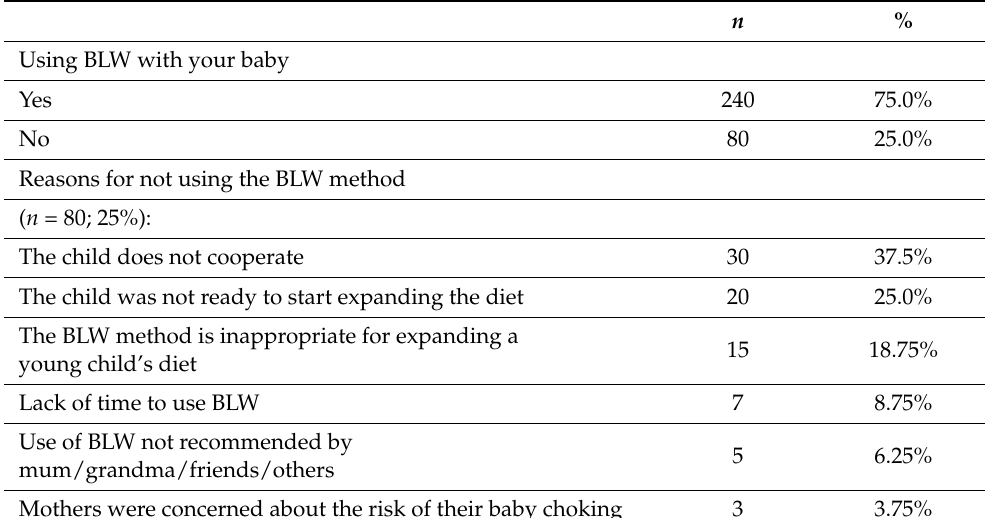
Table 2. Use of BLW in the surveyed group of